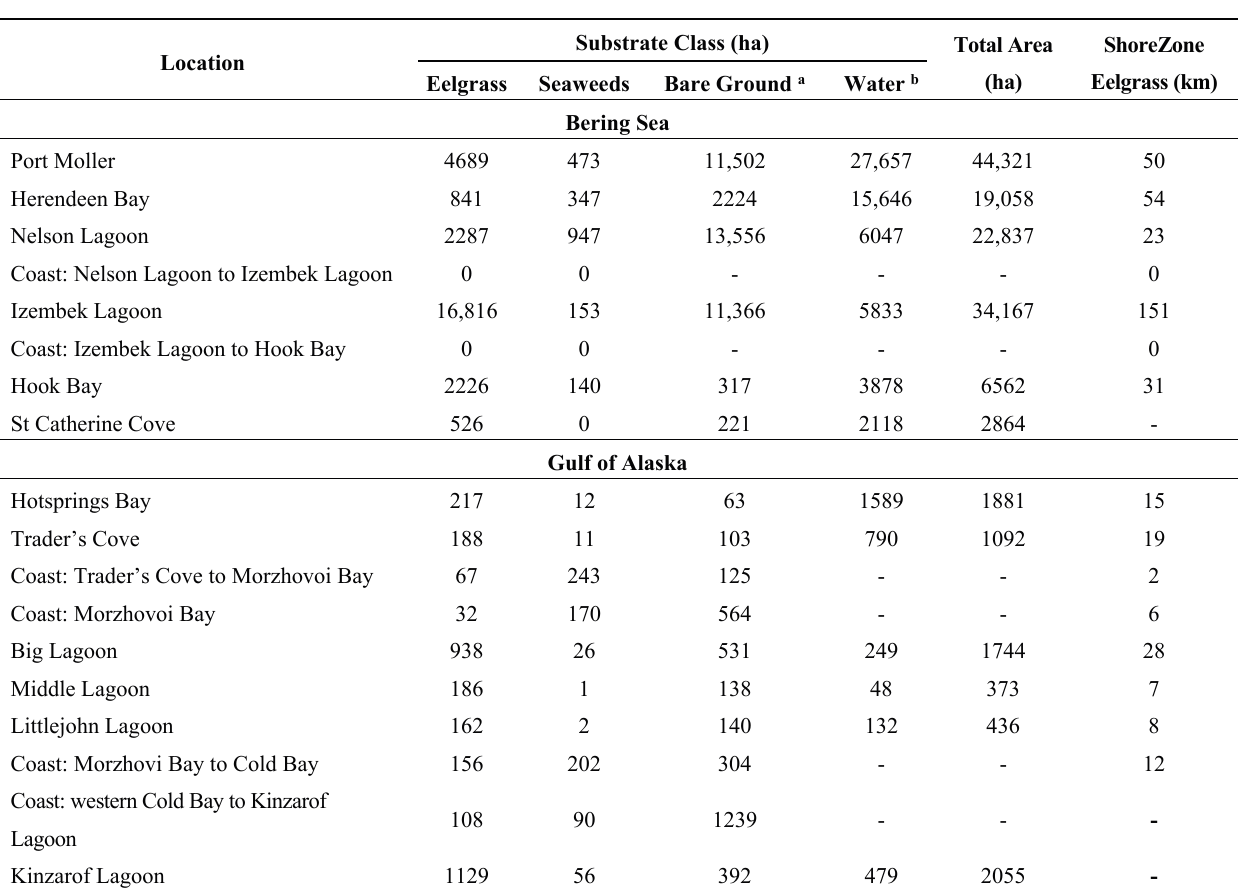
Table 2. Spatial extent estimates of eelgrass and other substrate classes on the lower Alaska